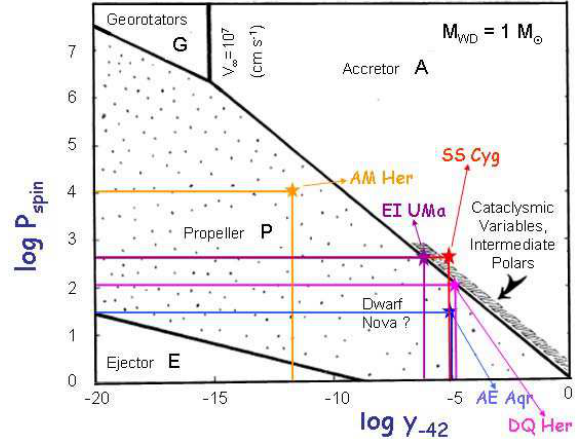
Figure 1: Lipunov’s diagram for gravimagneti rota- tors calculated for 1 M (cid:12) white dwarf. The positions of the polars AM Her and AE Aqr, and the intermediate polars DQ Her, EI UMa, and SS Cyg are marked (after Lipunov,